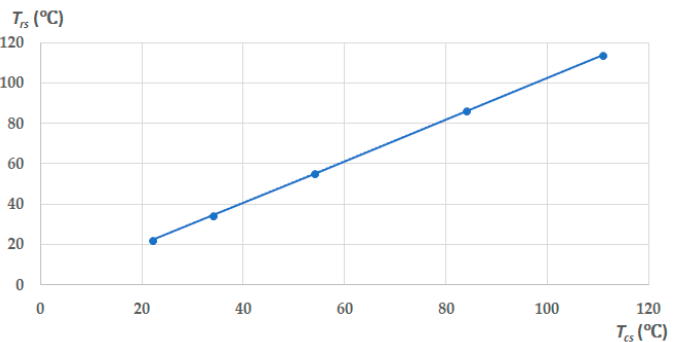
Figure 12. Relationship between the temperature of the point inside the case T rs and the temperature of the case T